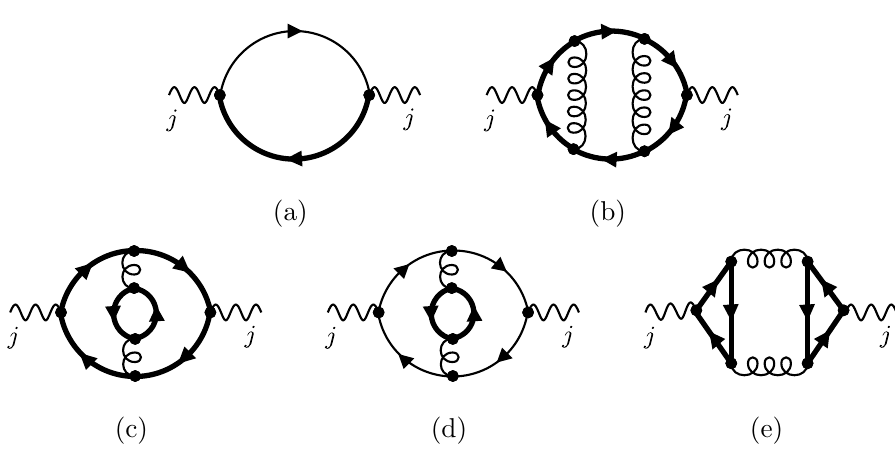
Figure 1 . Sample diagrams contributing to the perturbative calculation of the VPF, i.e., the left- hand side of eq. (2.2). The currents are symbolized by wavy lines, gluons by spirals. We consider the case where n l quarks are massless (thin straight lines), and n h quarks are degenerate with mass m (thick straight lines). (a) One-loop contribution for non-diagonal currents; (b-e) sample three-loop diagrams for diagonal currents. In (d), the currents couple to massless quarks. (e) is a \singlet" diagram. All diagrams in this paper were produced with the help of FeynGame